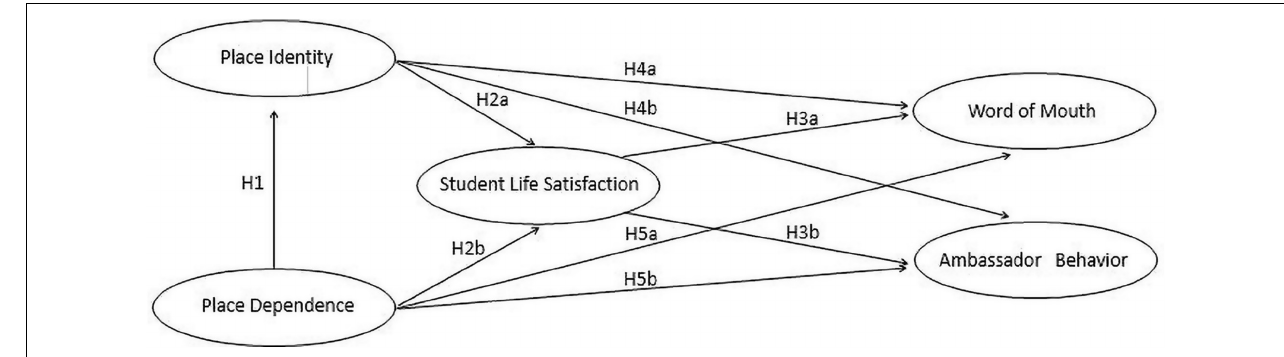
FIGURE 1 | Research